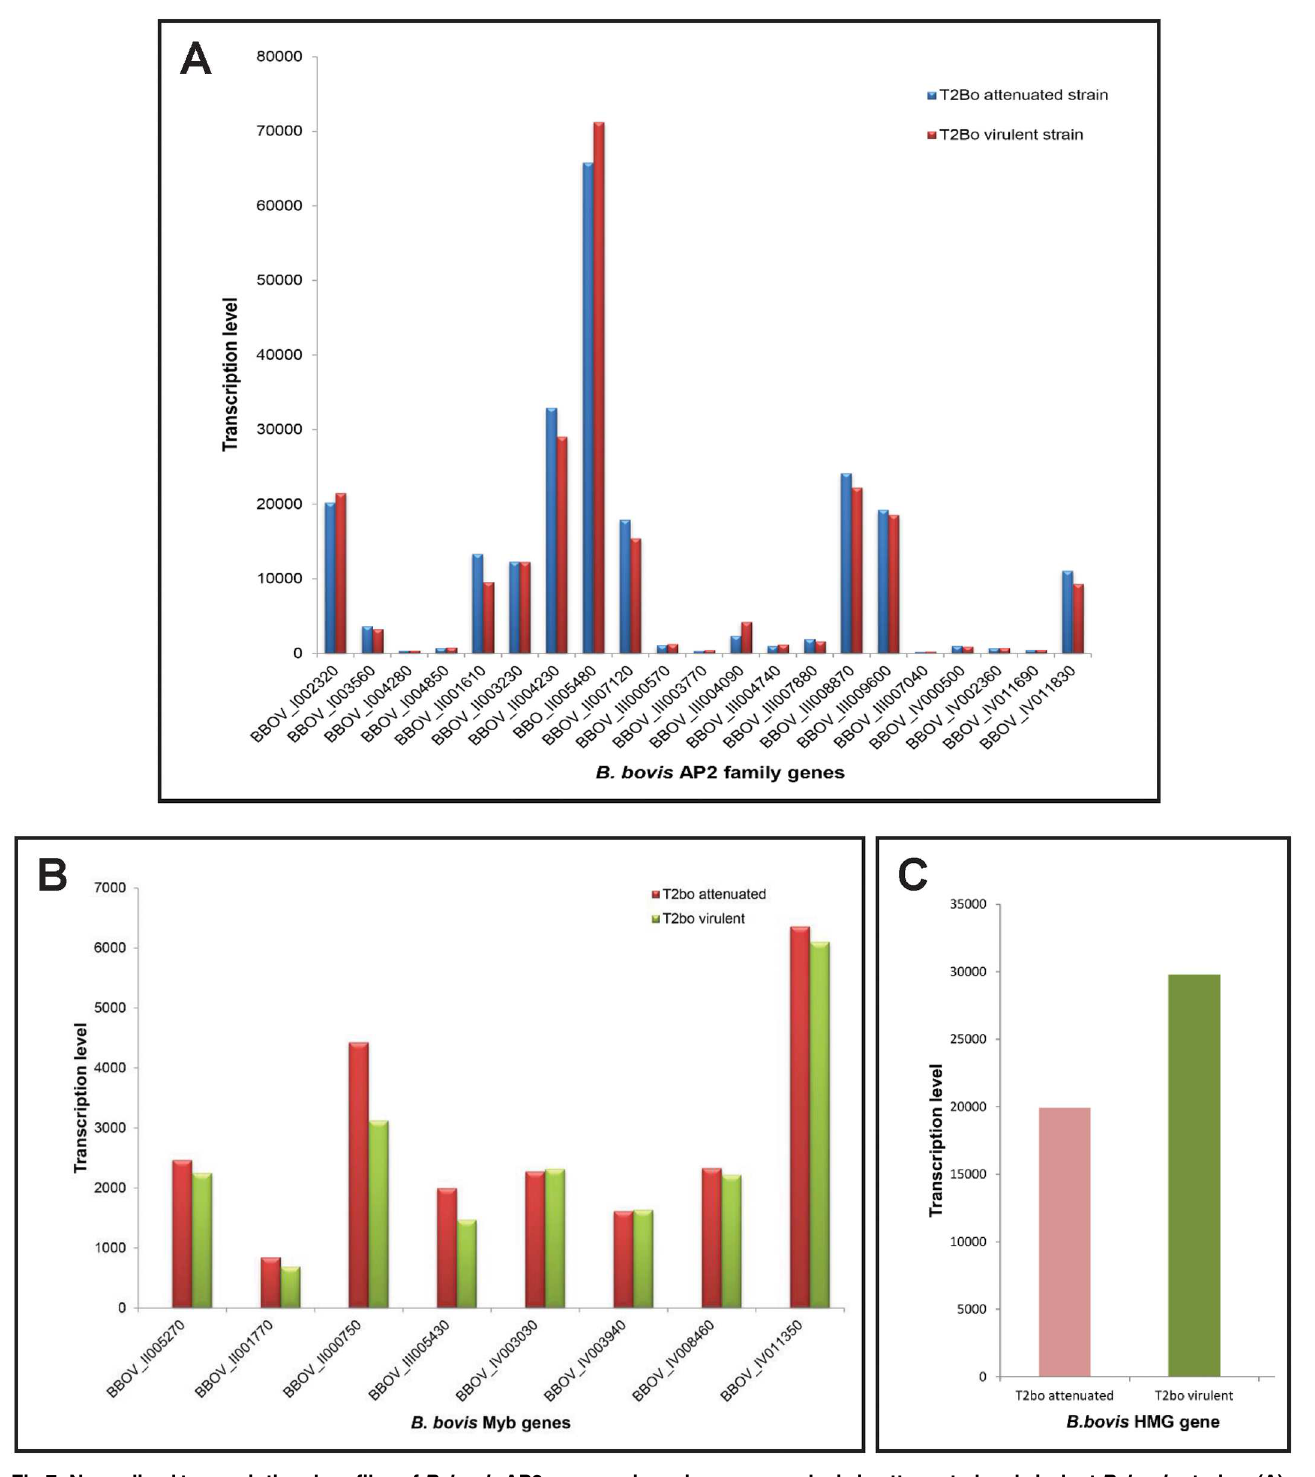
Fig 7. Normalized transcriptional profiles of B . bovis AP2 genes using microarray analysis in attenuated and virulent B . bovis strains. (A) Microarray transcriptionallevels expressed as relative transcription units log cpm (copy per million)are representedin the y -axis, and denominations for each B . bovis AP2 gene are represented in the x -axis. (B) Transcription profile of the eight Myb genes identifiedin the virulent and attenuated T2bo strains of B . bovis using microarray analysis. (C) Transcription profile of the BBOV_IV001910 HMG gene by microarray analysisin virulent and attenuatedT2Bo strain of B . bovis . The transcriptome analysiswas performed in triplicate on full blood stages of parasites developingin asynchronous cultures.